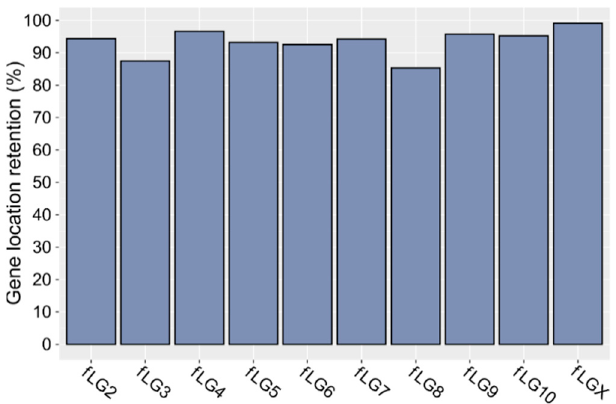
Figure 4. Retention of gene location between Tfree1.0 and Tcas5.2 assemblies. The bars show the percentage of T. freemani genes lifted from Tcas5.2 assembly that in Tfree1.0 retained location on a specific f LG chromosome corresponding to a specific LG chromosome in the Tcas5.2 assembly.